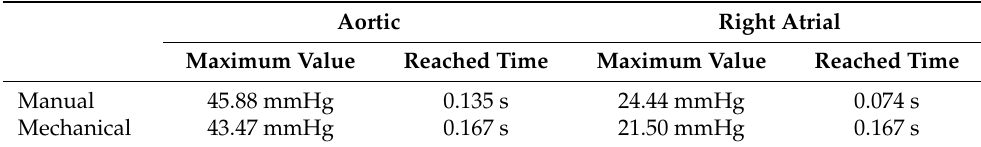
Table 3. Detailed blood pressure information with mechanical and manual waveforms. Aortic Right Atrial